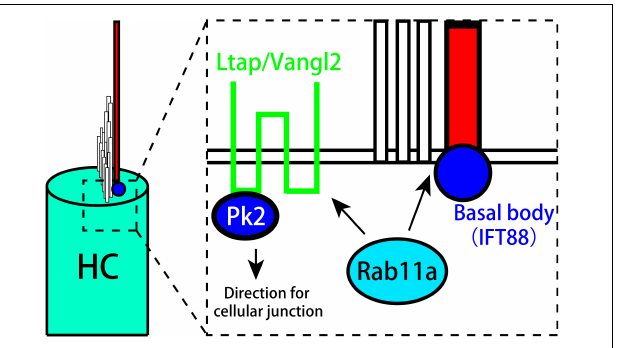
FIGURE 6 | Model showing the role of Rab11a in the formation of planar cell polarity in utricle. Rab11a intracts with Ift88 expressed in kinocilium basal body to affect the development of vestibular cilia. Besides, Rab11a affects the polarization of PCP core proteins including Vangl2 and Prickle2.